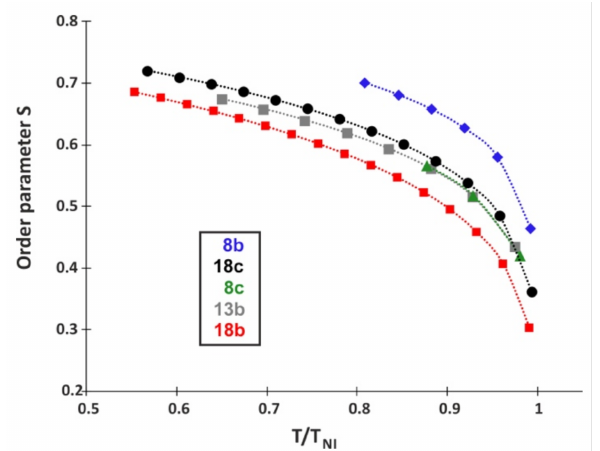
Figure 15. Temperature dependence of order parameter S for 8b , 8c , 13b , 18b , and 18c